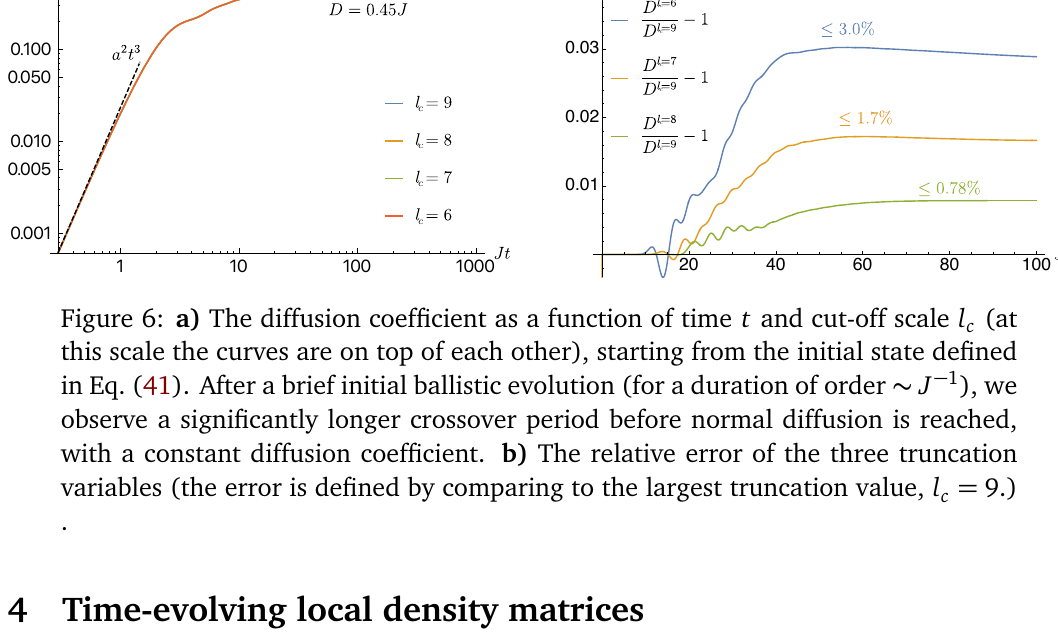
Figure 6: a) The diffusion coefficient as a function of time t and cut-off scale l this scale the curves are on top of each other), starting from the initial state defined in Eq. (41). After a brief initial ballistic evolution (for a duration of order ∼ J − 1 ), we observe a significantly longer crossover period before normal diffusion is reached, with a constant diffusion coefficient. b) The relative error of the three truncation variables (the error is defined by comparing to the largest truncation value, l